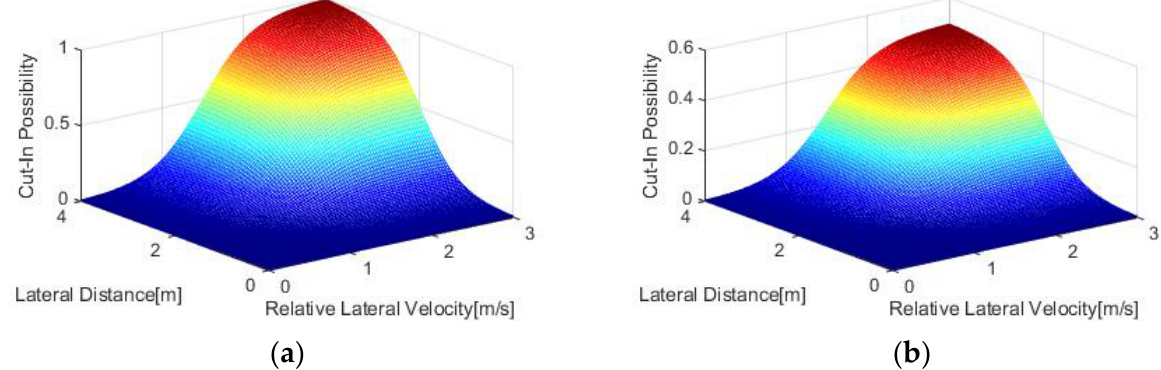
Figure 10. The cut-in possibility of under different weights: ( a ) the cut-in possibility under the weights of a straight lane. ( b )